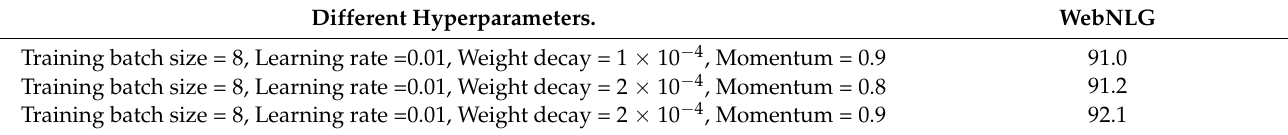
Bold marks the highest score.